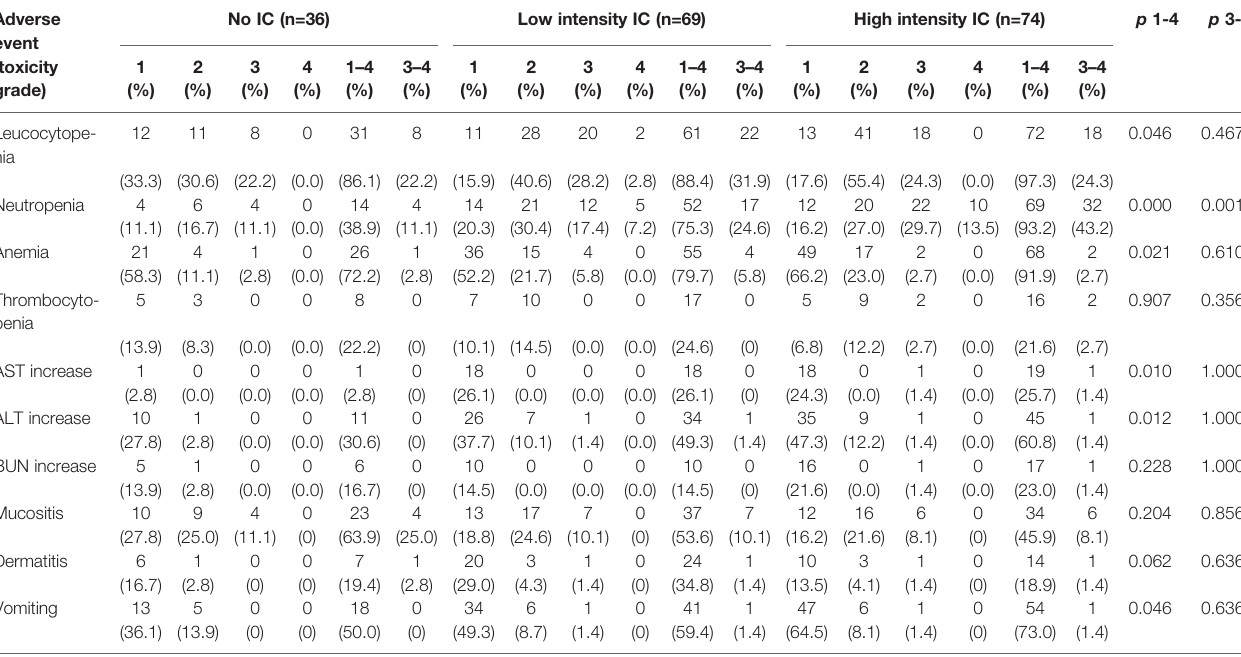
TABLE 4 | Cumulative acute adverse events during therapy by maximum grade per patient during therapy. Adverse event